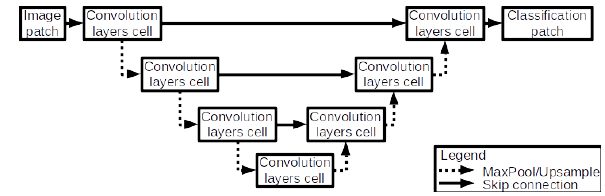
Figure 1. UNet-like general architecture.